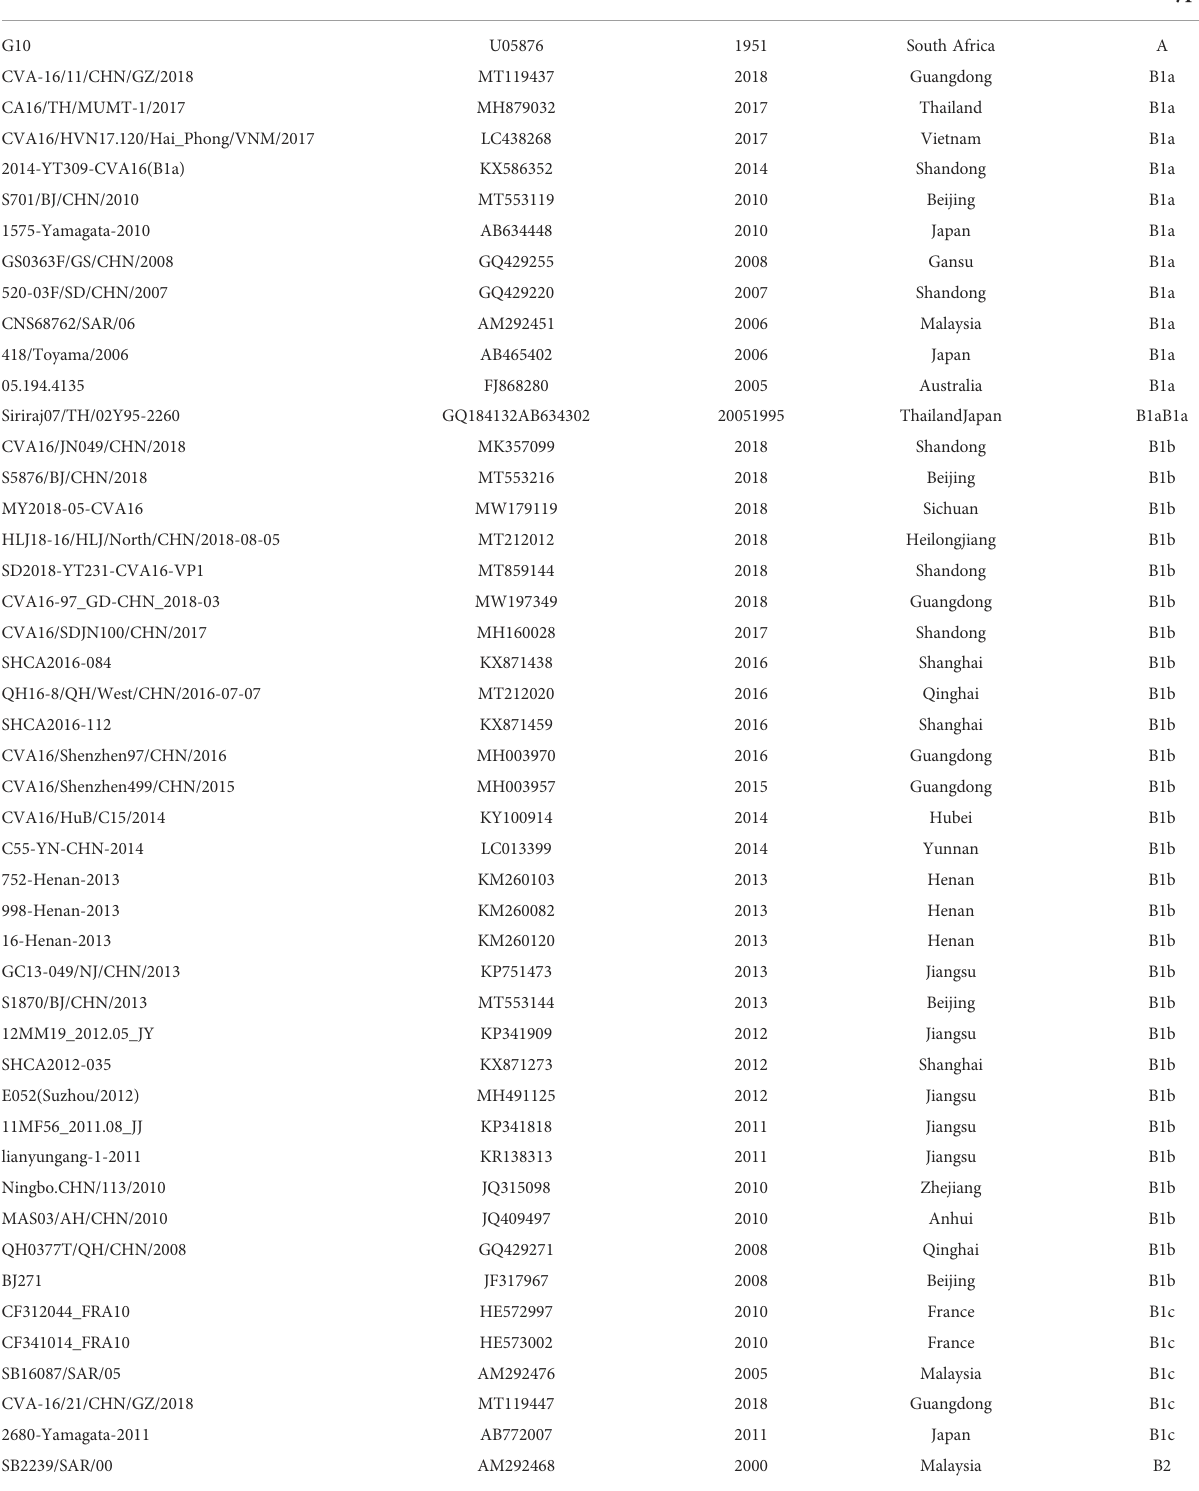
TABLE 1 Reference sequences used for plotting the phylogenetic tree in this